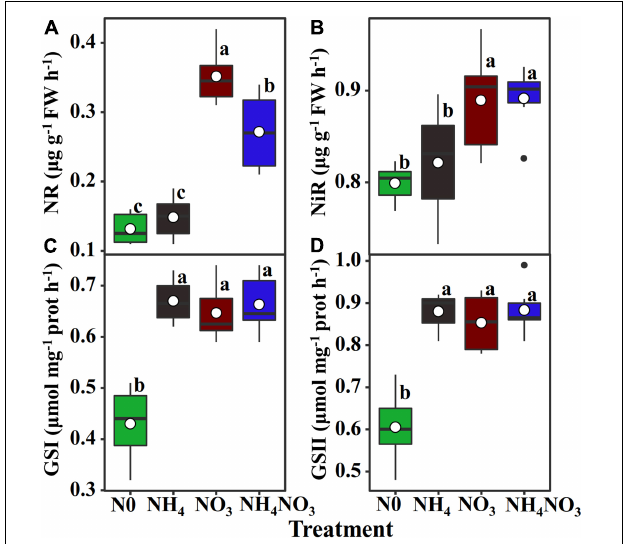
FIGURE 2 | Effect of N forms treatments on the changes in activities of nitrate reductase, nitrite reductase, and glutamine synthetase isoforms of leaves in L. chinensis . (A) Nitrate reductase (NR; EC. 1.6.6.1/2), (B) nitrite reductiase (NiR; EC. 1.7.2.1), (C) glutamine synthetase (GS) I, and (D) GS II. White dot is “Mean”; black dot is “Outlier”; horizontal is “Median”; the top of vertical line is “Max” and the bottom of vertical line is “Min.” The changes in activities of enzyme under N0, NH 4 , NO 3 , and NH 4 NO 3 treatments. Different lower-case letters indicate significant differences ( p < 0.05) ( n = 6).